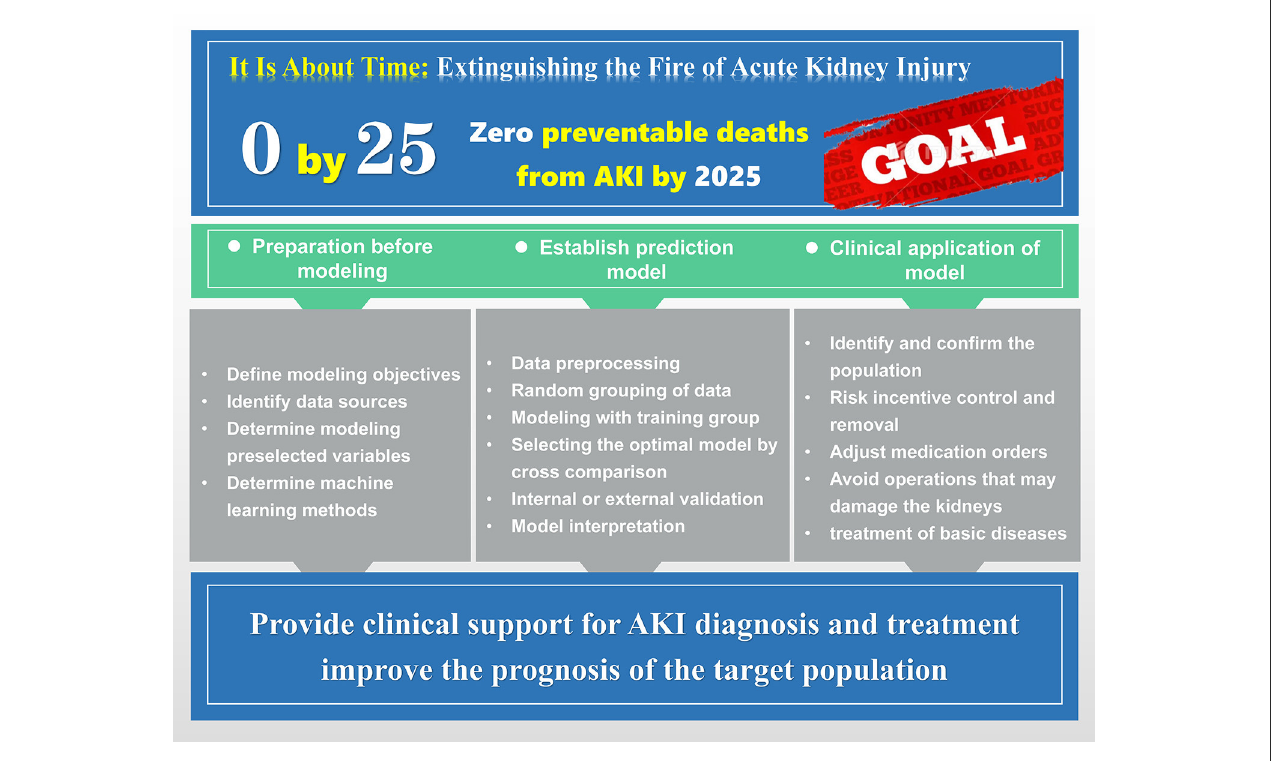
FIGURE1 The modeling idea and flow chart of machine learning prediction model. Including the preparation work before modeling, the specific process of model training, and the applicability of the final model to the patient